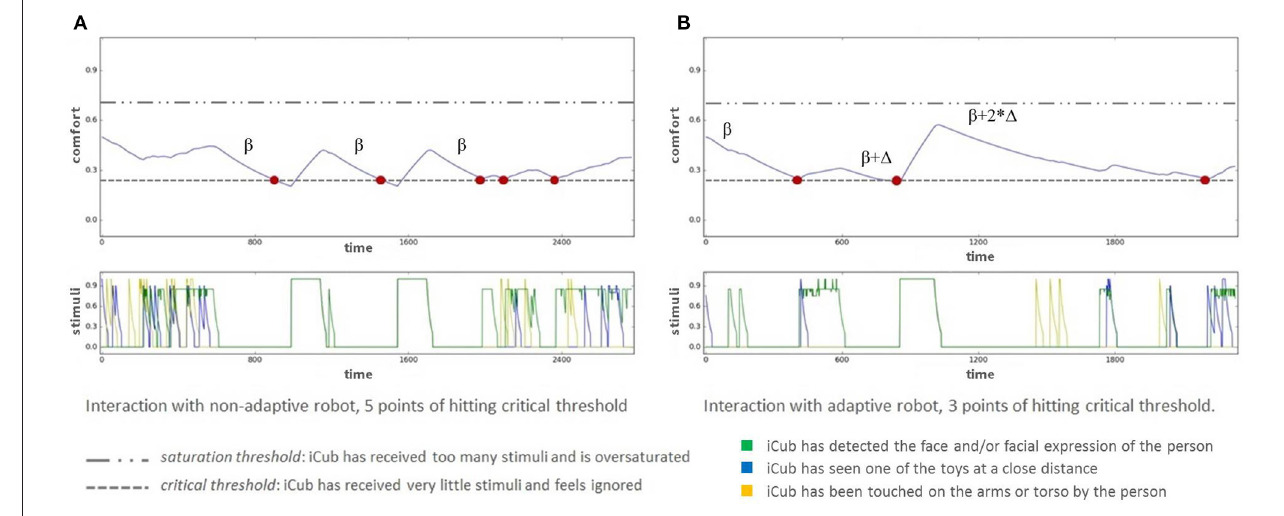
FIGURE 4 | Architecture dynamics: upper graphs depict the variations in iCub’s comfort value over the course of an interaction session, lower graphs depict the occurrence of stimuli. Critical hits are shown in red dots. (A) Sample FA participant interacting in the first Fixed session. The comfort value hits 5 times critical threshold, but the decay rate doesn’t change. (B) Sample AF participant interacting in the first Adaptive session. The comfort value hits three times the critical threshold. After each hit the decay value changes.